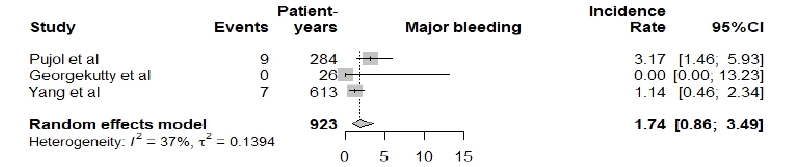
Figure A2. Forest plot of the incidence of major bleeding events in ACHD patients.